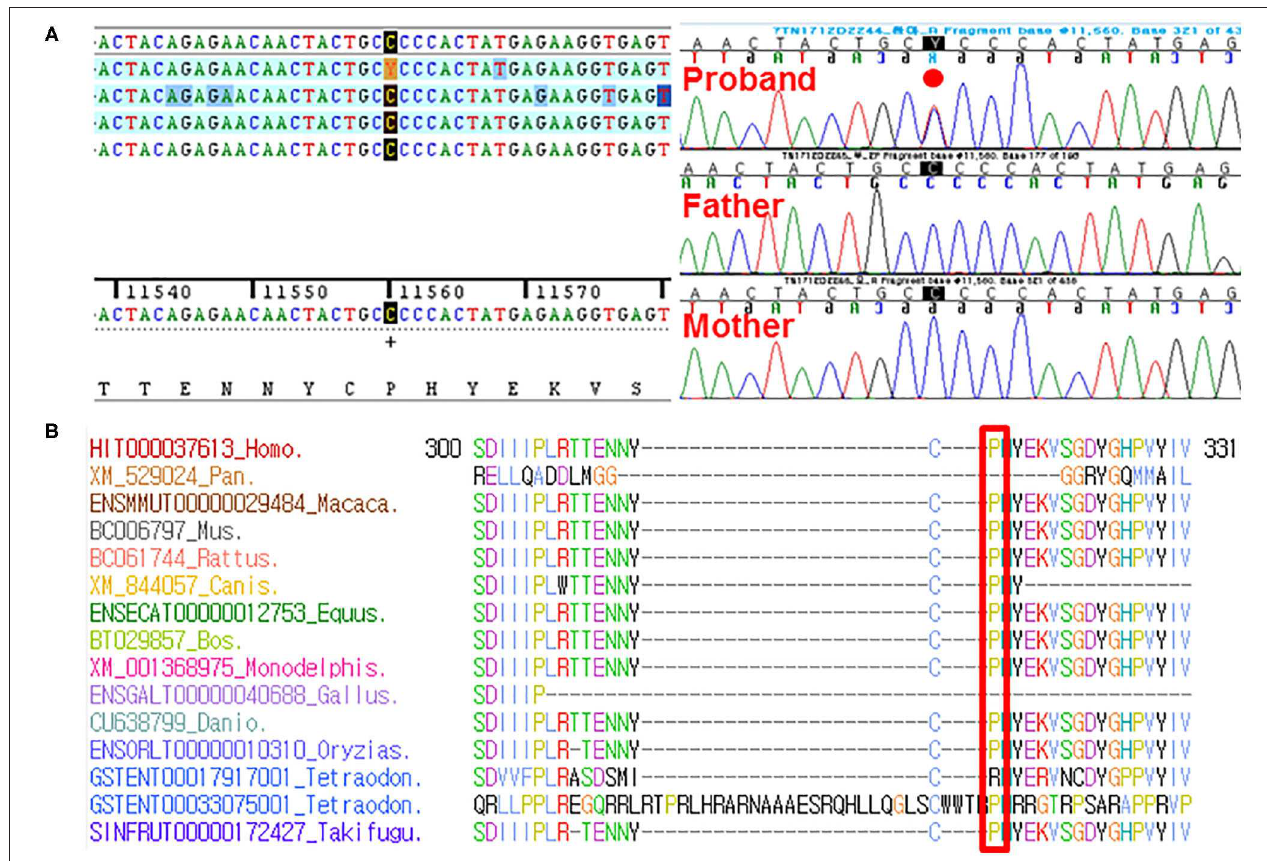
FIGURE 2 | (A) Sanger sequencing confirmed this heterozygous c.943C > T (p.Pro315Ser) in the EFNB1 occurring in a dominant de novo manner, as a consequence of phenotypic and genotypic wild type in both parents. (B) Sequence alignment of the conserved cytoplasmic domain of the EFNB1 protein in multiple species. Protein sequence of the Pro315Ser residue is highly conserved across species compared. It is highlighted in the red